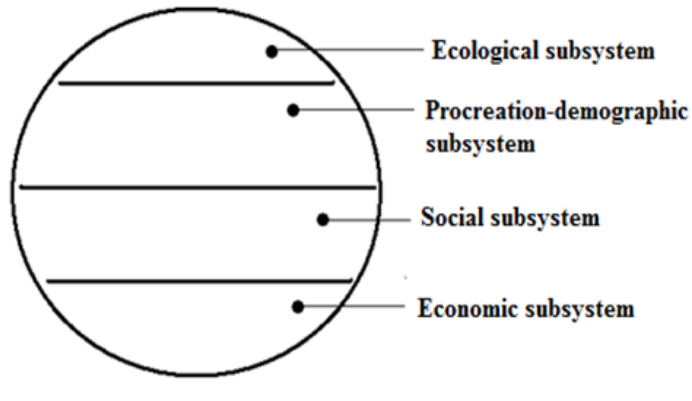
Figure 1. Representation of society as total sum of four classes of subsystems "drawn one on another"